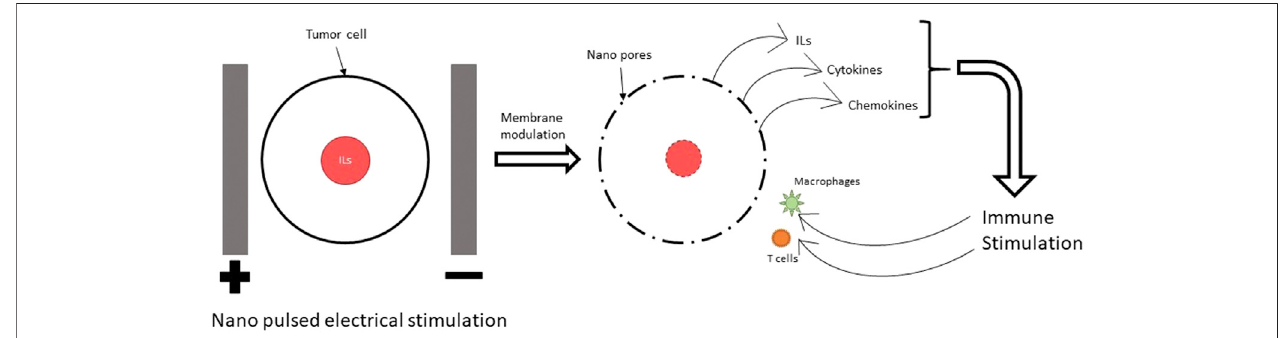
FIGURE 1 | Mechanism of immune modulation using NPS. The nano pulses of electric fi eld lead to electroporation (creation of pores in the cell and nuclear membrane) in cancer cells. This leads to release of ILs, cytokines and chemokines which trigger the immune system to attack the cancer